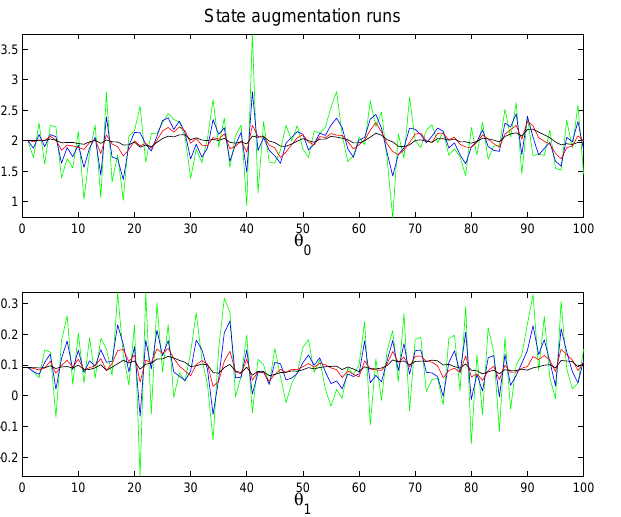
Fig. 12. Examples of too large model error: the model error vari- ance is multiplied with 100 and 1000. Too large model error in state augmentation will cause bias in the parameter values. Note that the rate of change of the parameters becomes smaller as the variance grows, although C θ is kept fixed in all runs. The straight lines rep- resent the means of the parameter